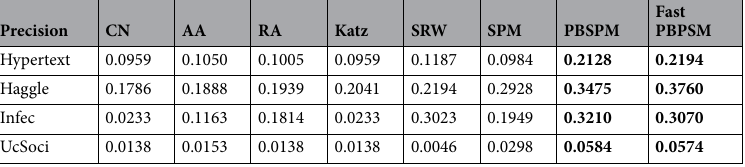
Table 1. Precision of different methods for four networks. All the results are calculated under the optimal cases by adjusting parameters if any. The data in bold face are averaged over ten realizations with the same p fresher and α